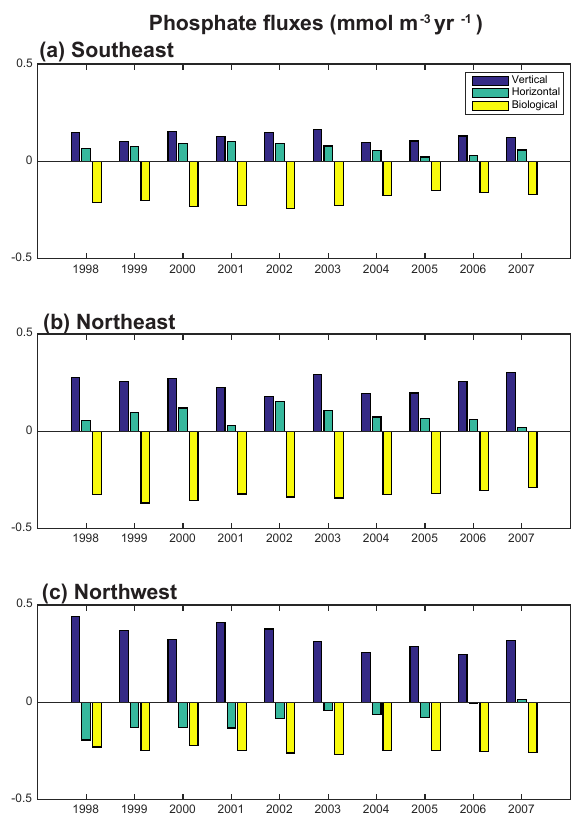
Figure 9. Phosphate diagnostics 1998–2007 annual time series: 0– 100m flux convergence (mmolm − 3 yr − 1 ) for the (a) SE region, (b) NE region and (c) NW